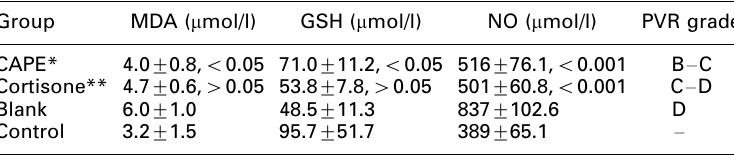
Table 1. PVR grades and MDA, GSH and NO levels in vitreous